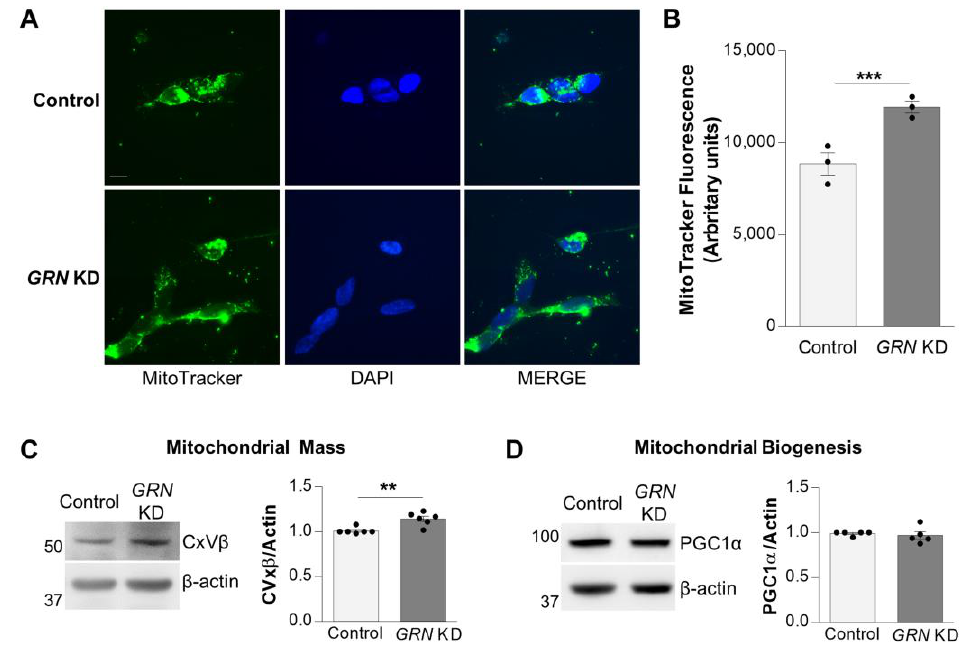
Figure 3. PGRN deficiency increases mitochondrial mass in SH-SY5Y cells. ( A ) Representative image of MitoTracker Green fluorescence in control and GRN KD SH-SY5Y cells. Fluorescence measurement was performed using a fluorescent confocal microscope and 63 × oil-immersion objective. Scale bar = 9µm. ( B ) Quantification of MitoTracker Green fluorescence in control and GRN KD SH-SY5Y cells. Fluorescence was assessed using a fluorescent microplate reader (Ex/Em = 490/516 nm). Plot represents the average ± SEM of three independent experiments. ( C ) Representative immunoblot showing the levels of the β subunit of mitochondrial Complex V (CxV β ) as a measurement of mitochondrial mass. β -actin was used as a loading control. Plot represents the average ± SEM of six independent measurements of CxV β levels. ( D ) Representative immunoblot showing the levels of the mitochondrial biogenesis marker PGC1 α . Plot represents the average ± SEM of five independent measurements of PGC1 α levels. β -actin was used as a loading control. For all the experiments, the statistical analysis was performed using Student’s t -test. ** p < 0.01; *** p < 0.001.